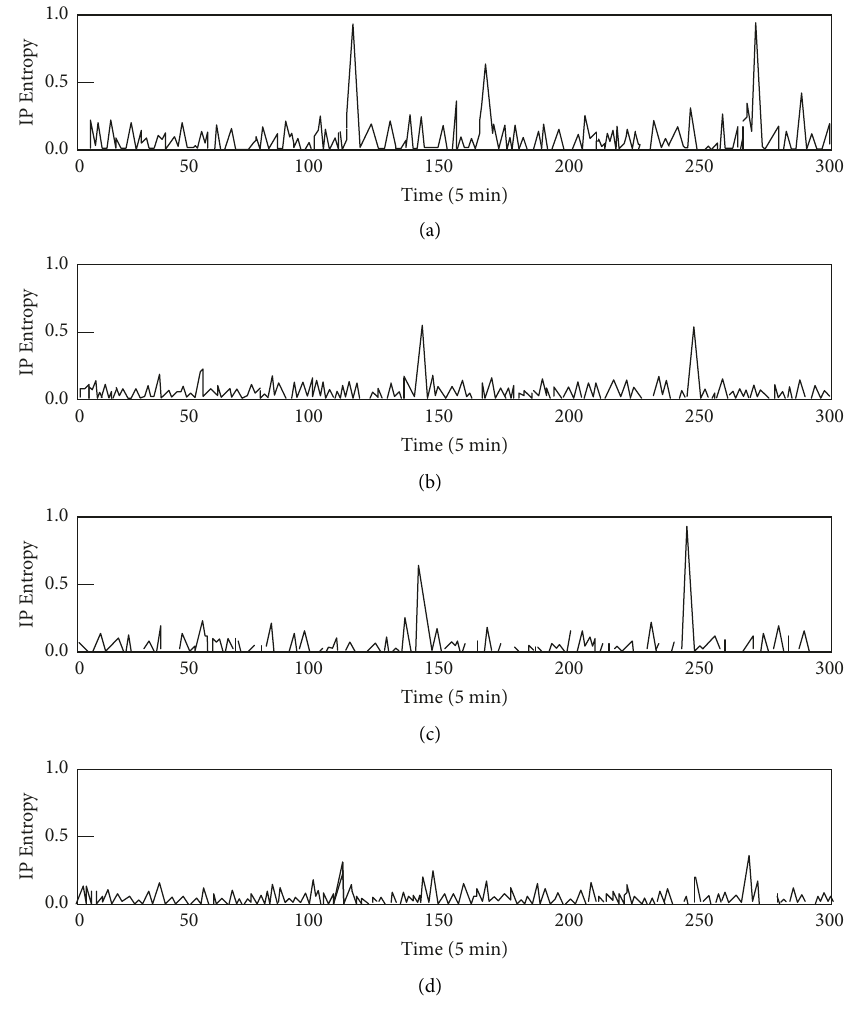
Figure 11: I P entropy change curves for different types of aggression. (a) Characteristics of traffic containing DDOS attack. (b) Traffic characteristics of worm propagation. (c) Traffic characteristics of network scanning. (d) Traffic characteristics of port